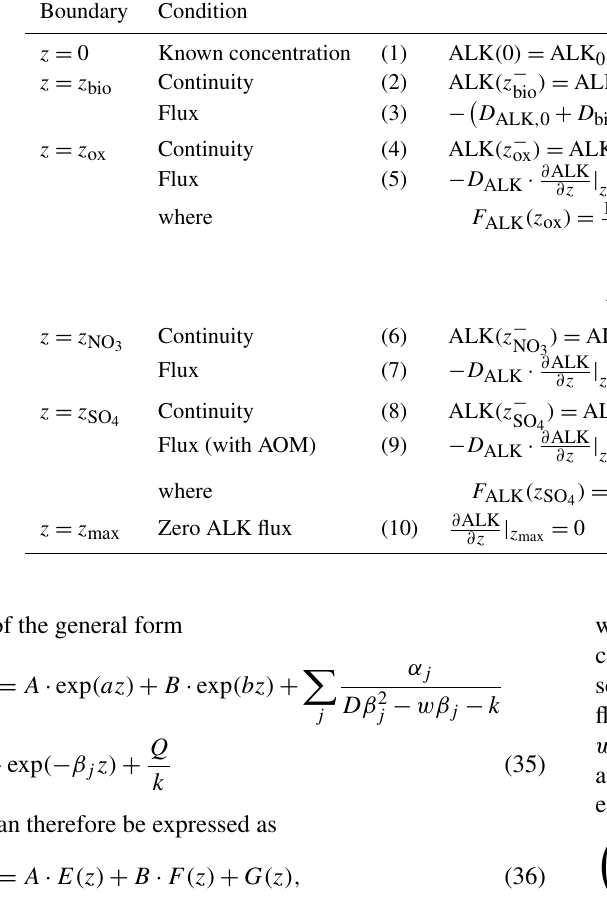
Table 8. Boundary conditions for alkalinity. For the boundaries we define z − __ = lim h → 0 (z __ − h) and z + __ = lim h → 0 (z __ + h) . Boundary